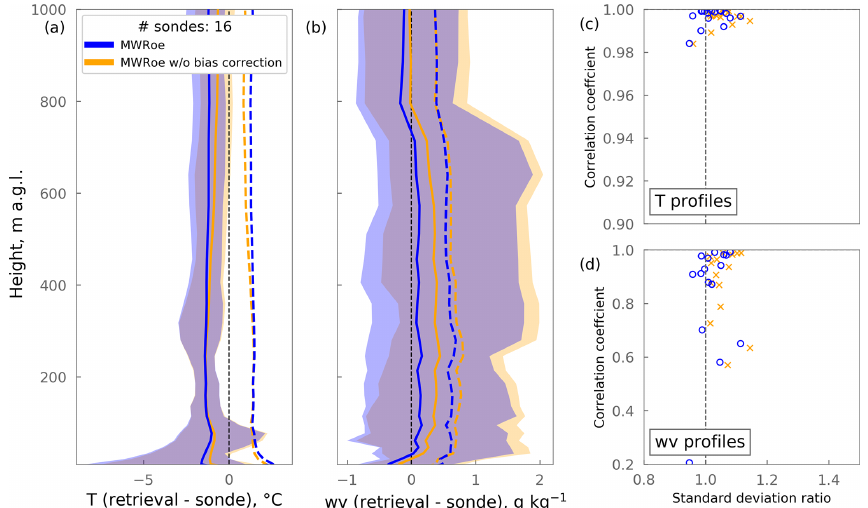
Figure A2. As Fig. 4 but comparing the performance of the final MWRoe retrieval (blue) with that of the MWRoe retrieval without the additional T b bias correction applied (orange). The solid line shows the mean bias and the shaded represents the range. Dashed lines show the root-mean-squared error